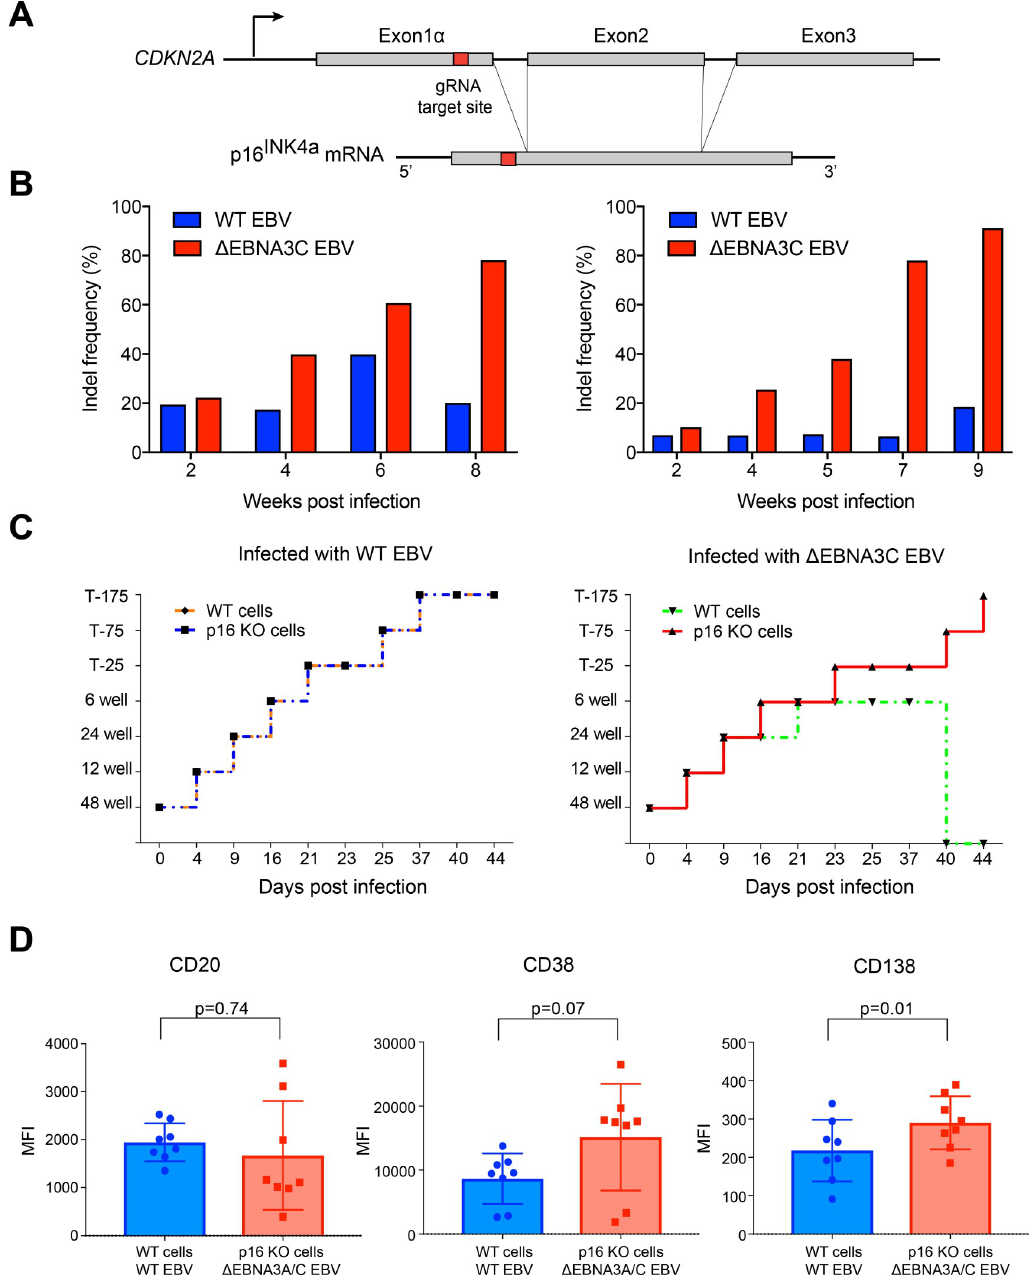
Fig 4. p16 INK4a is a functional barrier to EBV driven proliferation of lymphoblastoid cells. (A) Blueprint of the primary transcript and the spliced mRNA with the three exons of CDKN2A on chromosome 9 encoding the p16 INK4a protein. The target site of the RNP complex within the 1st exon (exon1 α ) (chr9:21,974,678–21,974,827) is shown. (B) Study of the biological effect of the CDKN2A knockout in a time course experiment. WT and p16 KO cells were mixed such that the fraction of the latter was in the order of 10 to 20%, when the cells were infected with WT or Δ EBNA3C EBV strains. The knockout status of the CDKN2A gene was studied by next generation sequencing to analyze the CD46 locus of the mixed cell populations over time. The fraction of cells with a disabled CDKN2A gene increased in cells infected with Δ EBNA3C EBV exceeding 80% after eight weeks, whereas the knockout status of CDKN2A in the population of cells infected with WT EBV did not show a clear trend. Results from two biological replicates are shown, additional replicates can be found in S4A Fig . (C) Cell numbers of four different B cell populations were plotted as a function of days post nucleofection (x-axis) versus the format of the cell culture vessel (y-axis) starting with a single well in a 48-well cluster plate. 2 × 10 6 B cells with an intact CDKN2A locus (WT cells) or cells with an edited CDKN2A gene (p16 KO cells) were infected with wild-type (WT) EBV (left panel) or Δ EBNA3C EBV (right panel). WT